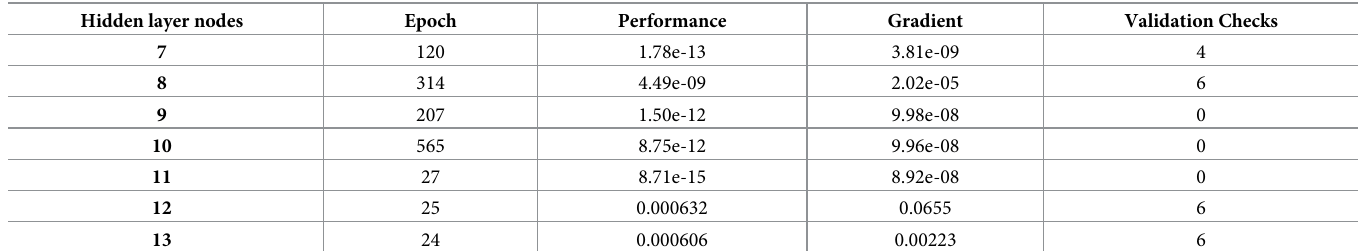
Table 2. Comparison of prediction with different hidden Layer Nodes (LM).